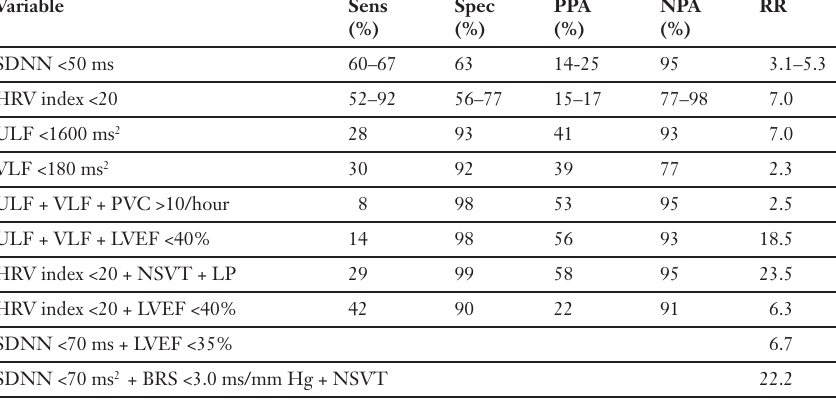
Table 4 Sensitivity, speci- ficity, predictive ac- curacy and relative risk of heart rate vari- ability alone or com- bined to other non- invasive markers for post-myocardial risk